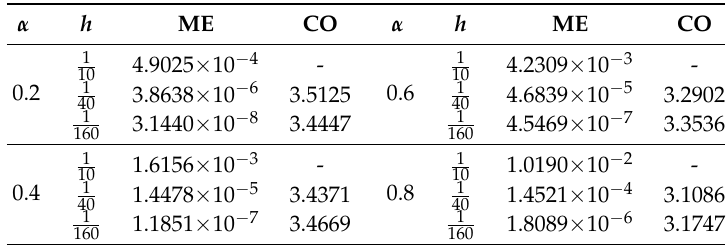
Table 5. Numerical results for Example